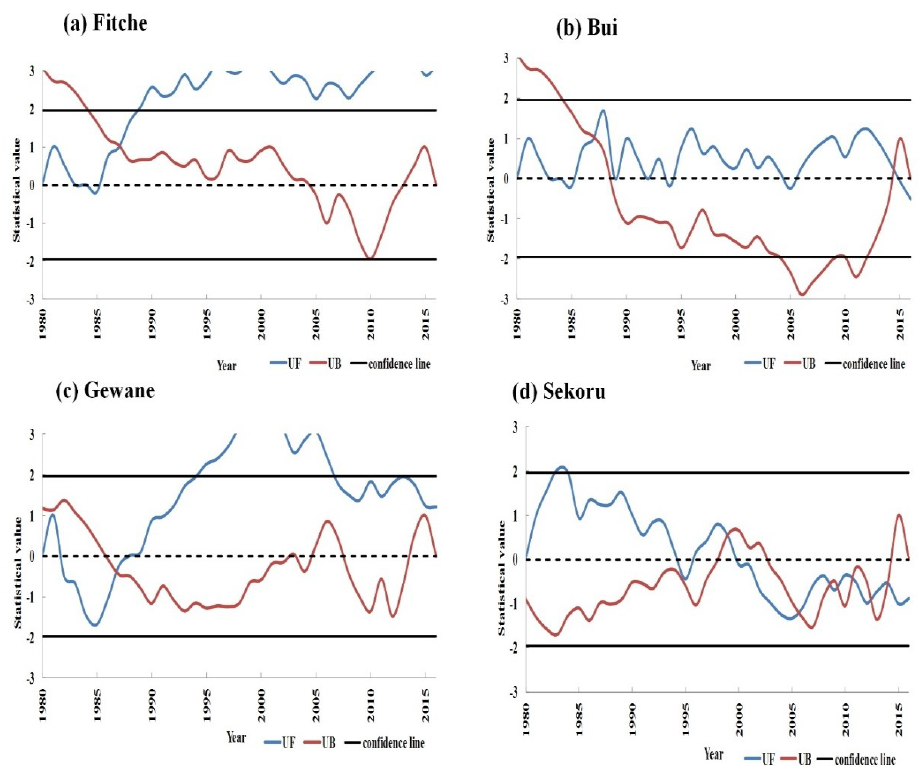
Figure 2. Annual Mann–Kendall (MK) statistical values of precipitation. Table 4. Results of MK, innovative trend analysis method (ITAM), and Sen’s slope estimator tests for precipitation.